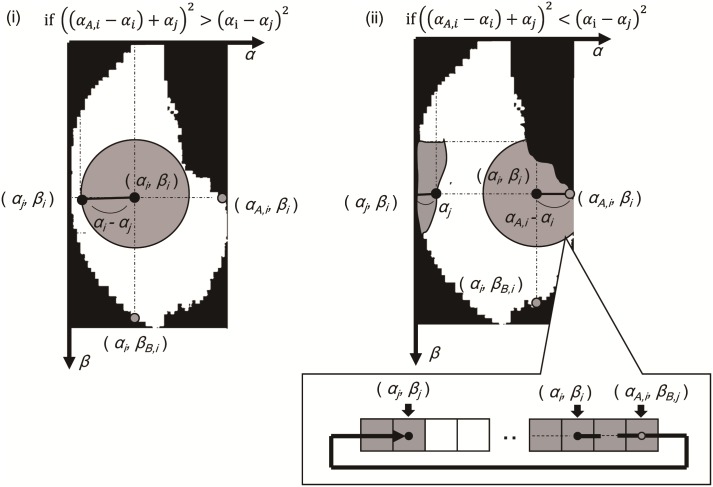
Configuration of synapse connections.The figure represents the connection range of a mitral or a granular unit. A unit at the center of the grey circle is connected to all units within a range of the circle. If the connection range exceeds the limit, it is folded back to the other end, considering the bulbous shape of the olfactory bulb, using Eqs (7)–(12).